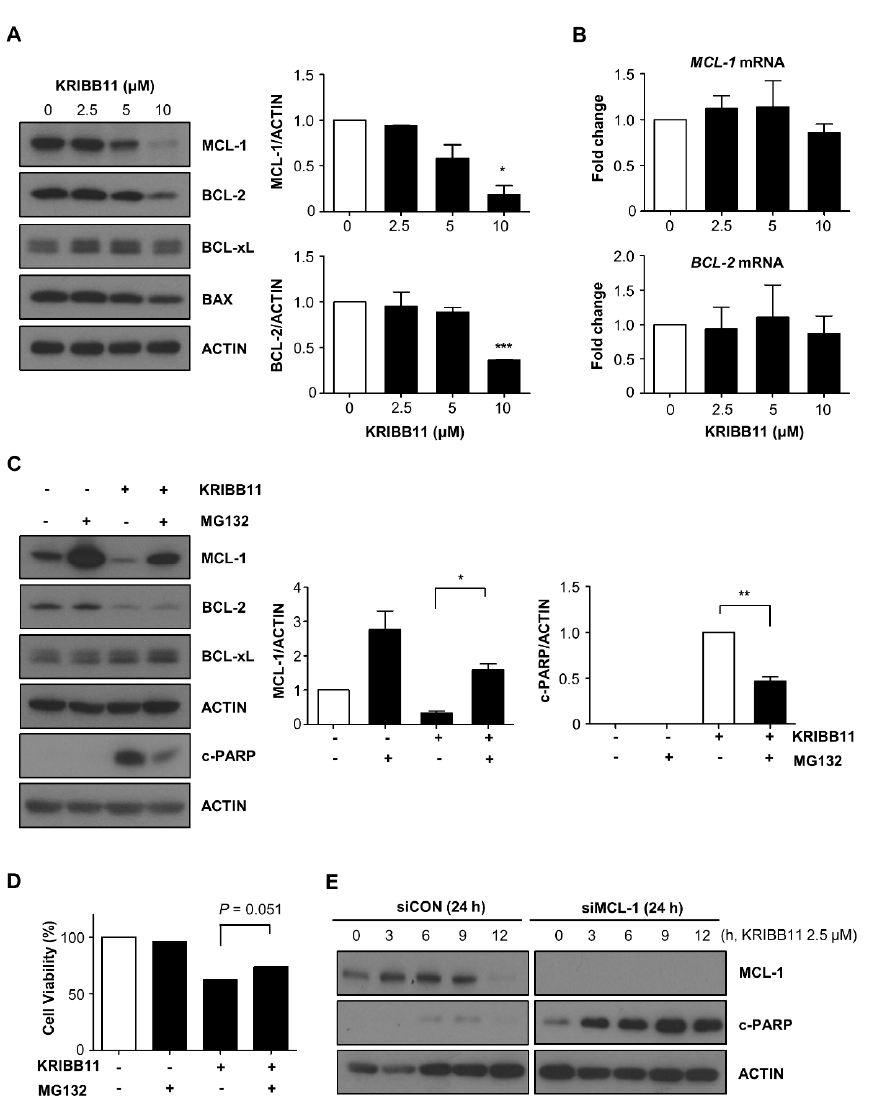
Figure 2. KRIBB11 decreases MCL-1 expression, which was restored by MG132. ( A ) Western blot analysis for expression of MCL-1, BCL-2, BCL-xL, and BAX in A172 cells treated with the indicated dose of KRIBB11 for 48 h ( left ). Quantification of relative levels of MCL-1 or BCL-2 protein were determined by normalizing to β -Actin as in Figure 1 ( right ). ( B ) qRT-PCR analysis for MCL-1 and BCL-2 mRNAs after exposure to the indicated dose of KRIBB11. ( C ) Effect of proteasome inhibition was examined using MG132. A172 cells were treated with 10 µ M of KRIBB11 for 24 h and subsequently with 10 µ M of MG132 for another 4 h followed by Western blotting analysis ( left ). The alteration of MCL-1 and c-PARP levels upon MG132 treatment was presented by densitometric analysis after normalizing to the β -Actin ( right ). ( D ) After treatment as in ( C ), A172 cells were washed with phosphate-buffered saline and then further incubated for 48 h. The relative cell viability was determined by MTT assay. ( E ) Effect of MCL-1 depletion on the KRIBB11-induced apoptosis by transfection 50 nM of MCL-1 specific siRNA and the Western blotting for MCL-1 and c-PARP. Data are presented as means ± SE of three independent experiments. * p < 0.05, ** p < 0.01, and *** p < 0.001 with respect to the control values ( A ) or between indicated groups ( C